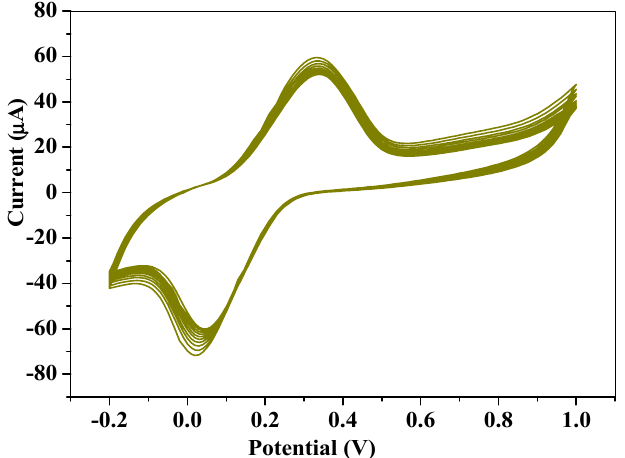
Figure 14. 10 repetitive CV scans in 0.1 mM DA at 25 mVs − 1 scan rate.